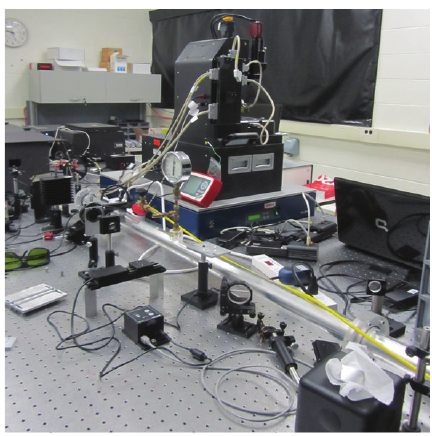
Figure 1: Experimental set up: laser head and fixing system.